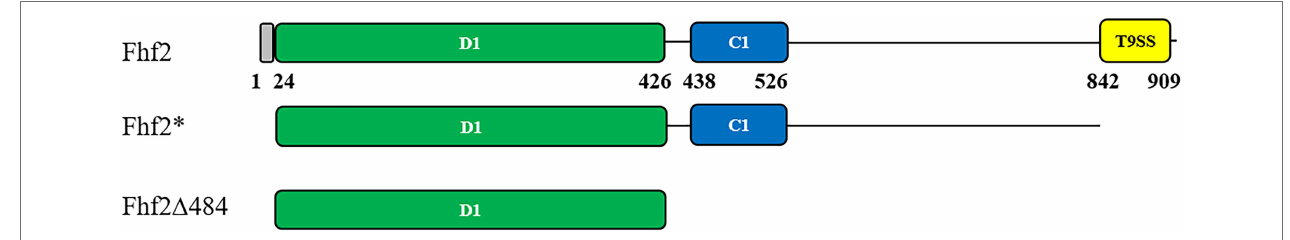
FIGURE 1 | Predicted protein domain structures of Fhf2 and Fhf2 Δ 484. Numbering corresponds to amino acids in the full-length Fhf2 sequence. Predicted domains are indicated with the amino acid numbers and in colors. Grey: secretion signal peptide, green: D1 domain; cyan: cadherin-like superfamily domain (IPR015919); yellow: a secretion system C-terminal sorting domain (IPR026444). Fhf2* is the full-length gene for heterologous expression in Escherichia coli devoid of the N-terminal signal peptide as well as the C-terminal T9SS domain. The C-terminal deletion mutant Fhf2 Δ 484 only contains the predicted catalytic D1 domain.